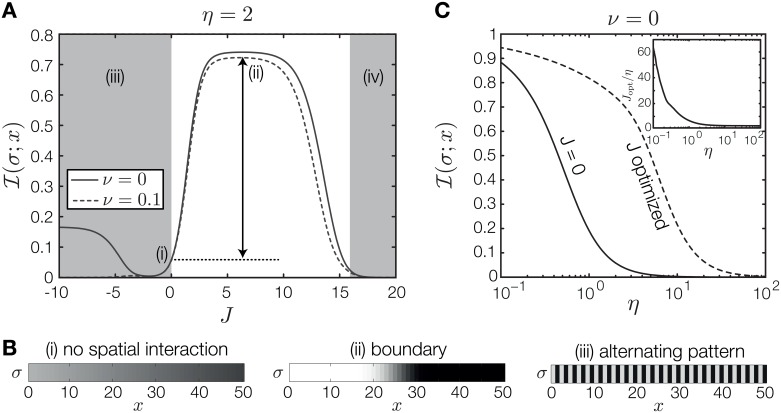
Effect of spatial interactions on one patterning gene.(A) PI as a function of spatial interaction strength J with fixed intrinsic noise η = 2 and two levels of extrinsic noise (legend). The arrow indicates the excess PI available to an optimally spatially coupled system, relative to an uncoupled (J = 0) system. At nonzero extrinsic noise (ν = 0.1) PI is strongly suppressed at J < 0. (B) The average spatial pattern for three regions denoted in (A): (i) no spatial interaction; (ii) positive J stabilizes a pattern with a boundary against noise; (iii) negative J results in an alternating pattern. In region (iv) indicated in (A) the strength of spatial interactions forces the pattern in a uniform all ON or all OFF state that carries 0 bits of positional information. (C) Comparison between PI with (dotted line) and without (solid line) spatial interaction as a function of intrinsic noise, η. For the spatially coupled system an optimal Jopt has been found separately for each value of intrinsic noise η. The corresponding values of Jopt, scaled by the respective noise levels η, are plotted in the inset.